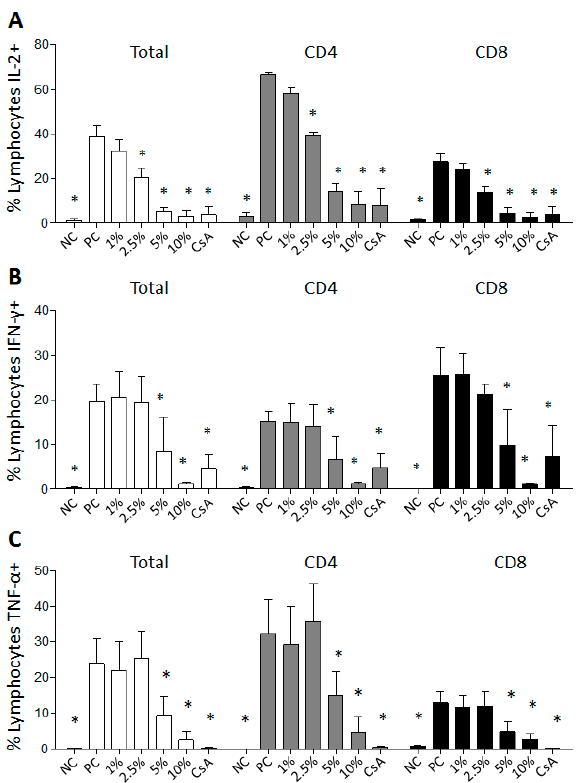
Figure 4. Dymethyl sulfoxide (DMSO) effect on the production of interleukin-2 (IL-2) ( A ), interferon- γ (IFN- γ ) ( B ) and tumor necrosis factor- α (TNF- α ) ( C ) in lymphocytes populations. Analysis of total lymphocytes, CD4 + and CD8 + relative percentage that were positives for cytokines in non-stimulated and untreated (NC), stimulated with phorbol-12-myristate-13-acetate (PMA) (PC) and stimulated with PMA cells culture in the last 4 h in a total of 8 h of DMSO treatment at 1, 2.5, 5, or 10% v/v or with 5 μ g/mL of cyclosporine (CsA). Results were expressed as mean and standard deviation (SD). * Statistically significant difference when compared to PC ( p < 0.05, one-way ANOVA followed by